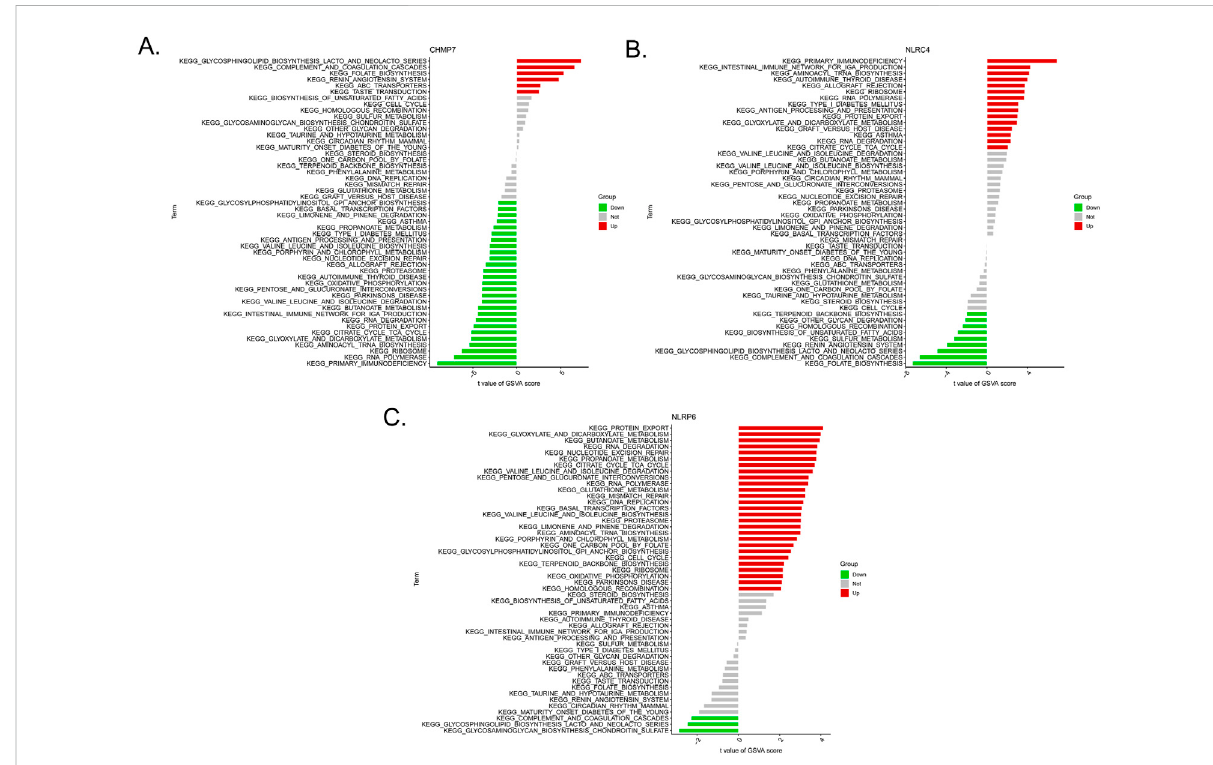
FIGURE 6 Low- and high-expression groups based on the levels of expression of each marker gene combined with GSVA in CHMP7 (A) , NLRC4 (B) , and NLRP6 (C)